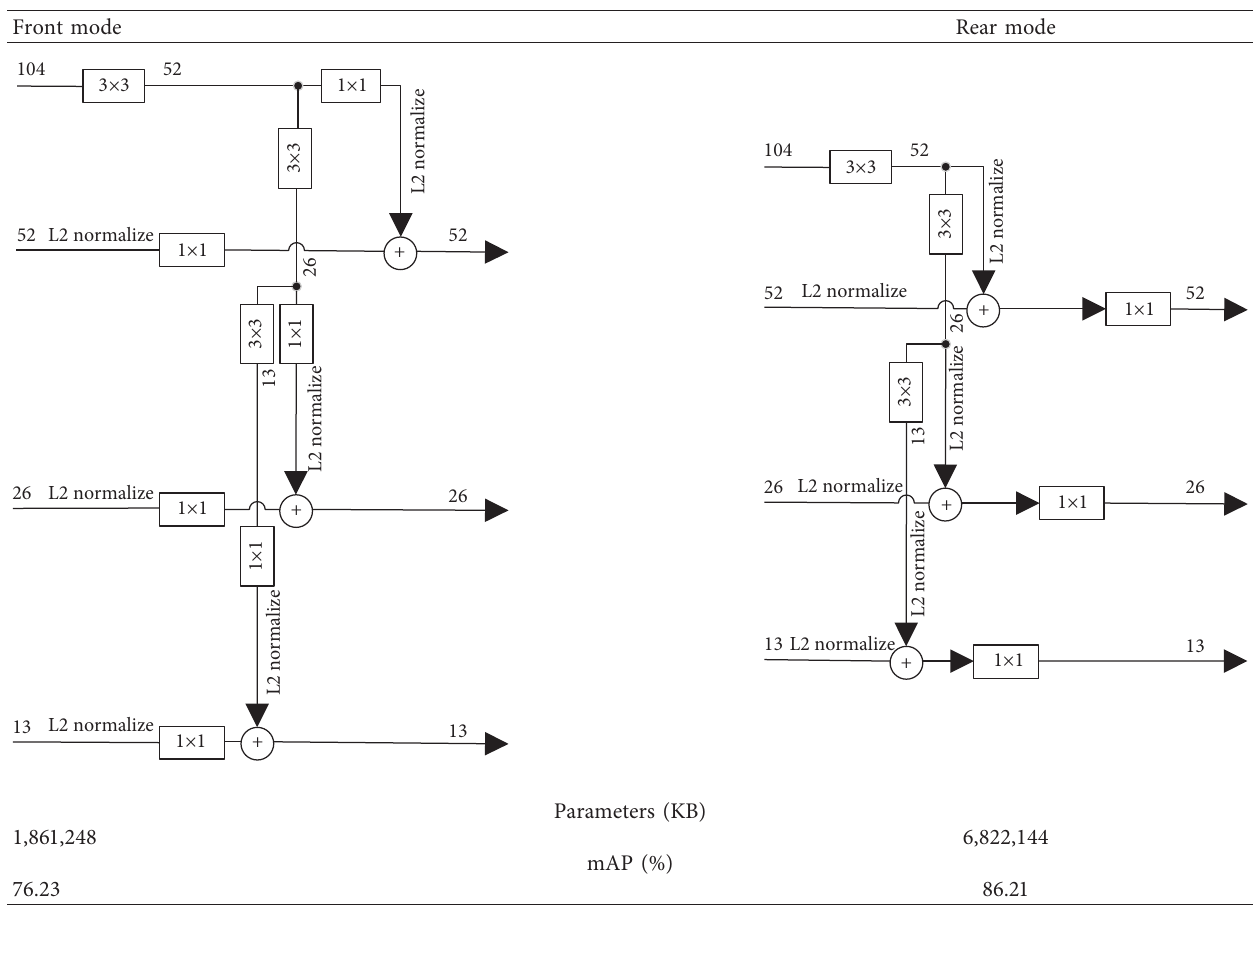
Table 6: Parameters and mAP in two different placement modes, and parameters and accuracy in two different placement modes. Front mode